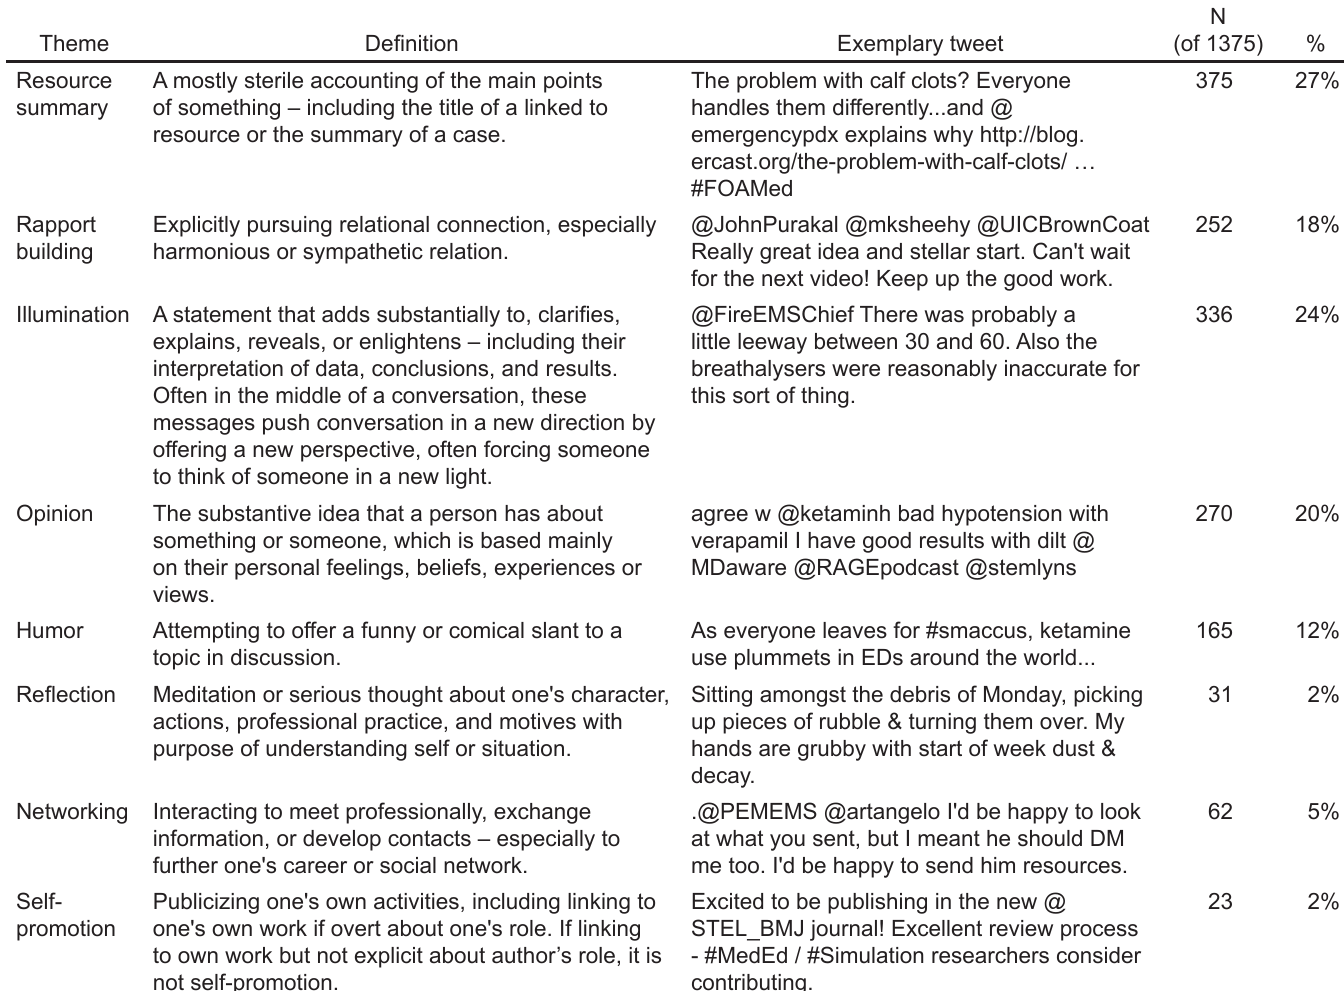
Table 3. Thematic categories of tweets of influential emergency